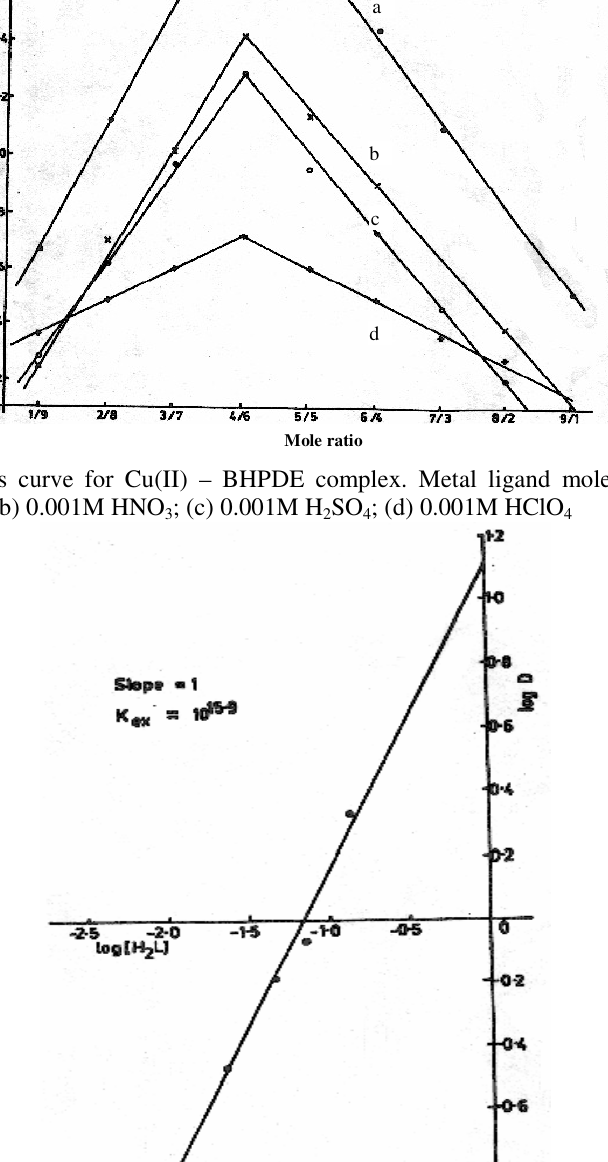
Figure 2. Effect of initial concentration of BHPDE on the distribution of